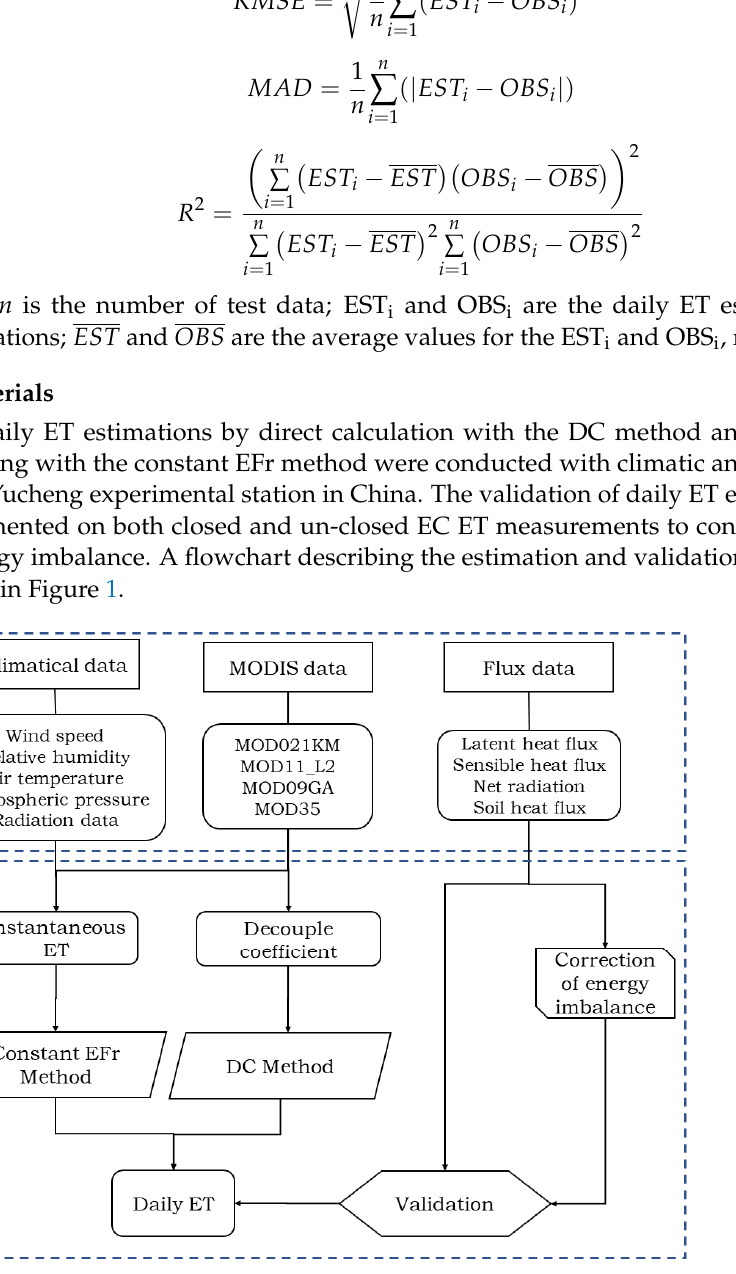
Figure 1. Flowchart of daily ET estimation and validation procedures through the DC method and the constant EFr method.